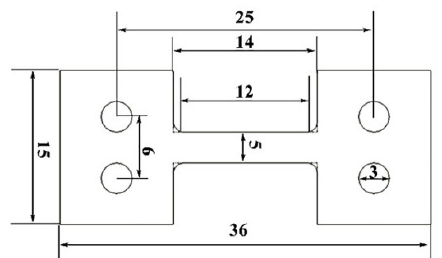
Figure 1. Schematic diagram of the tensile sample for in situ observation (unit: mm).